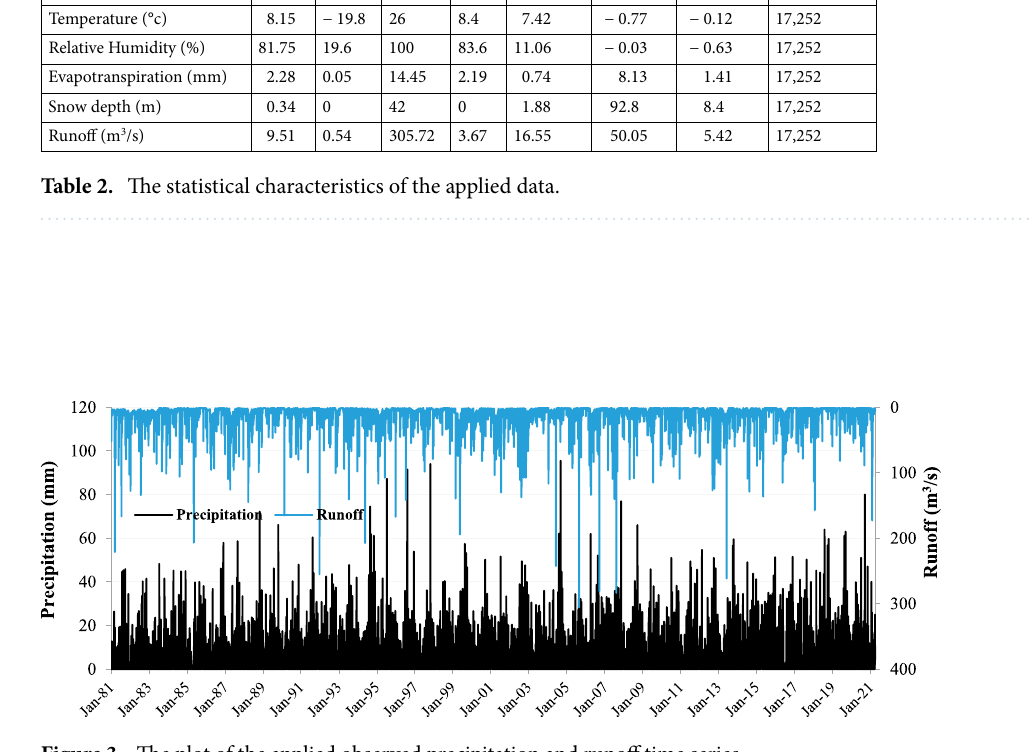
Figure 3. The plot of the applied observed precipitation and runoff time